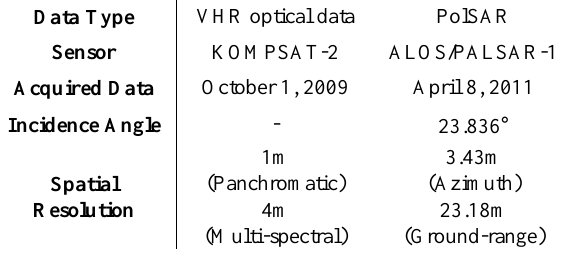
Table 2. Description of the remote sensing data